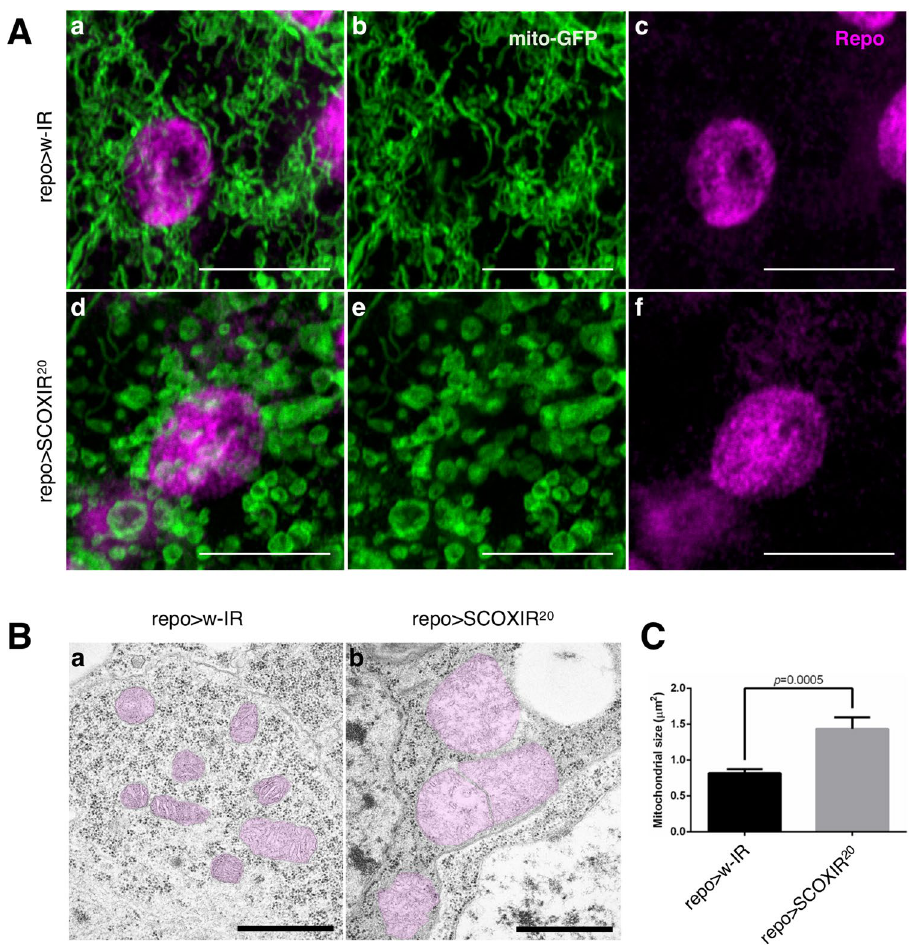
Figure 2. Glial cell-specific Scox knockdown results in morphological aberrations of mitochondria in third instar larvae. ( A ) The mitochondria in the glial cells of the CNS in third instar larvae were visualized with the mito-GFP reporter (green). The nuclei of glial cells were labeled with anti-Repo antibody (magenta). The scale bar indicates 10 µm. (a–c) UAS-mito-GFP/+; repo-GAL4/w-IR , (d–f) UAS-mito-GFP/UAS-SCOXIR 20 ; repo- GAL4/ +. ( B ) The mitochondria in the glial cells on the surface of the larval CNS were observed by transmission electron microscopy. The mitochondria are marked in pink. The scale bar indicates 1 µm. ( C ) Mitochondrial size in glial cells of the CNS was measured and quantified. w -IR; n = 61, SCOXIR 20 ; n = 58. repo > w-IR ( repo-GAL4/ UAS-w-IR ), repo > SCOXIR 20 ( UAS-SCOXIR 20 / + ; repo-GAL4/